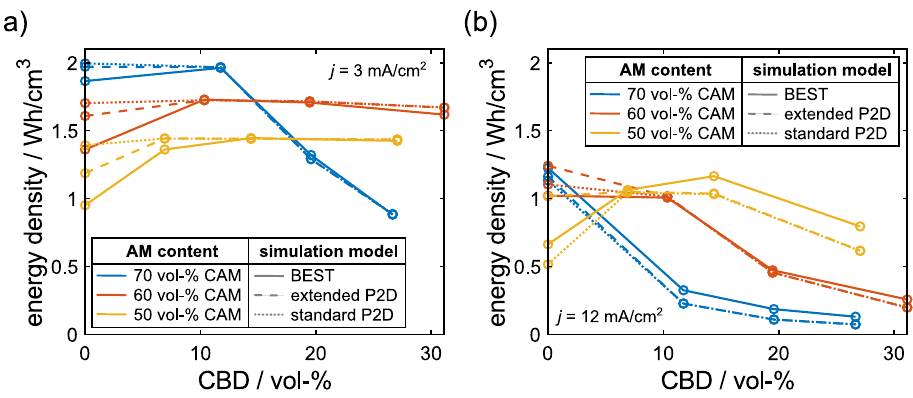
Figure 10. Comparison of predicted energy densities of 3D microstructure-resolved (solid line) and P2D simulations using the standard (dotted) and extended (dashed) model for the solid phase conductivity. Colors represent different CAM contents. ( a ) current density of 3 mA/cm 2 and ( b ) current density of 12 mA/cm 2